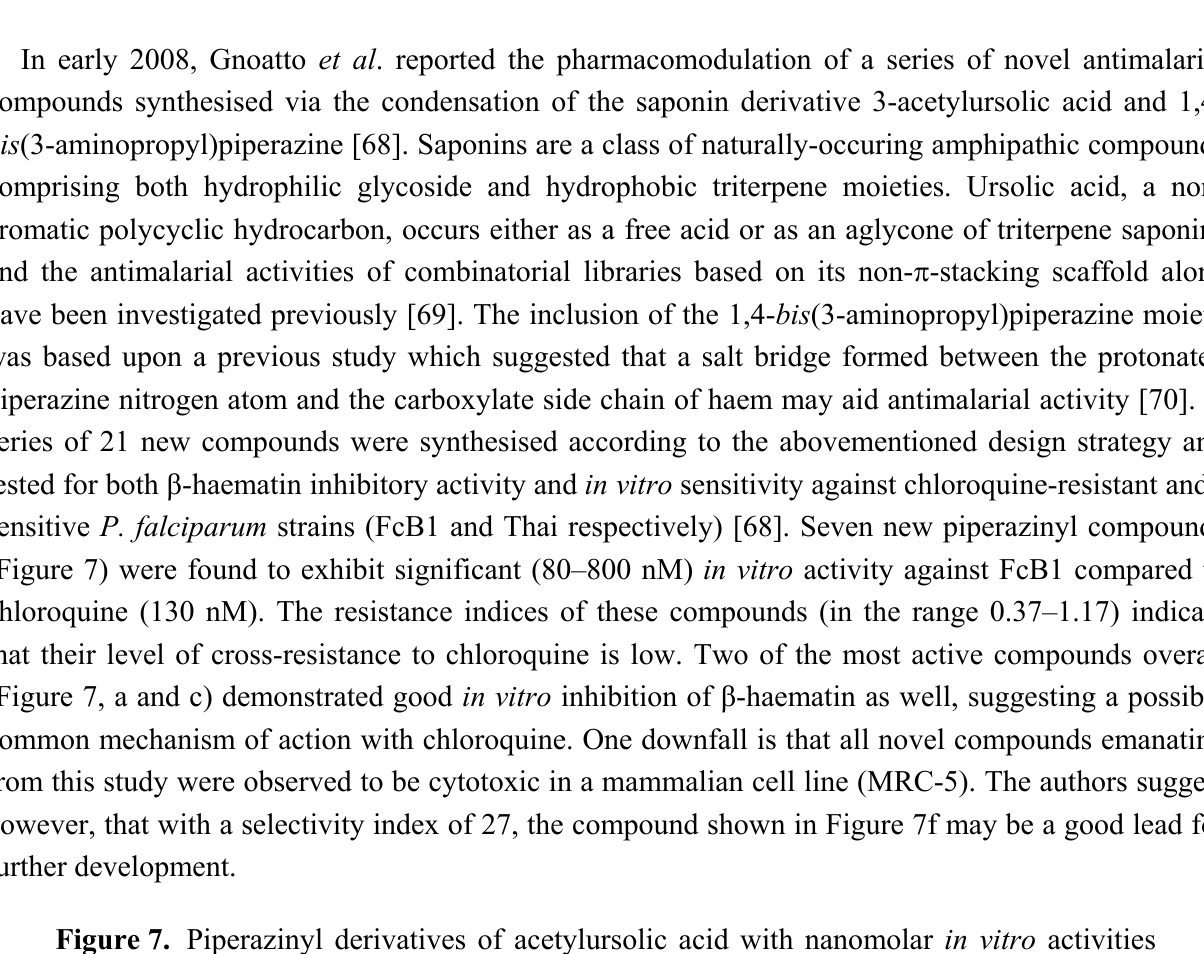
= R = H, (b) the deacetylated version of (a), (c) R 1 2 = R = methylcyclopropyl, (e) R 1 2 = H, R = methylferrocenyl. 1 2